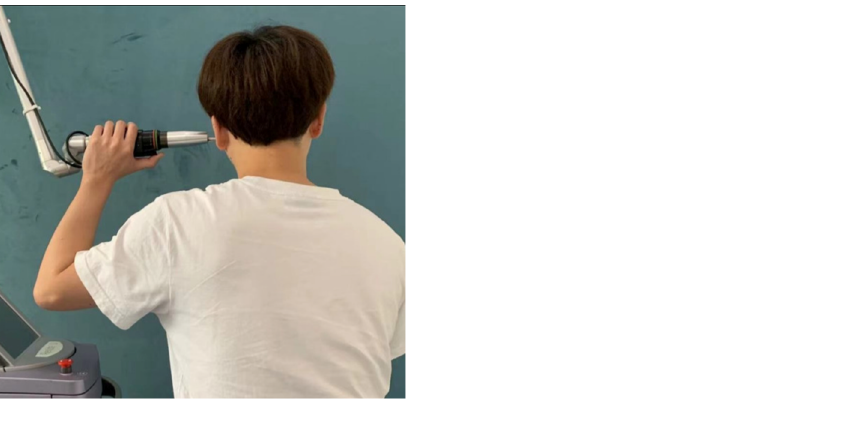
Figure 2. Therapeutic ultrasound (US). (Figure from [88], https://pubmed.ncbi.nlm.nih.gov/34140803/#&gid=article-figures&pid=figure-1-uid-0 (accessed on 18 November 2022).